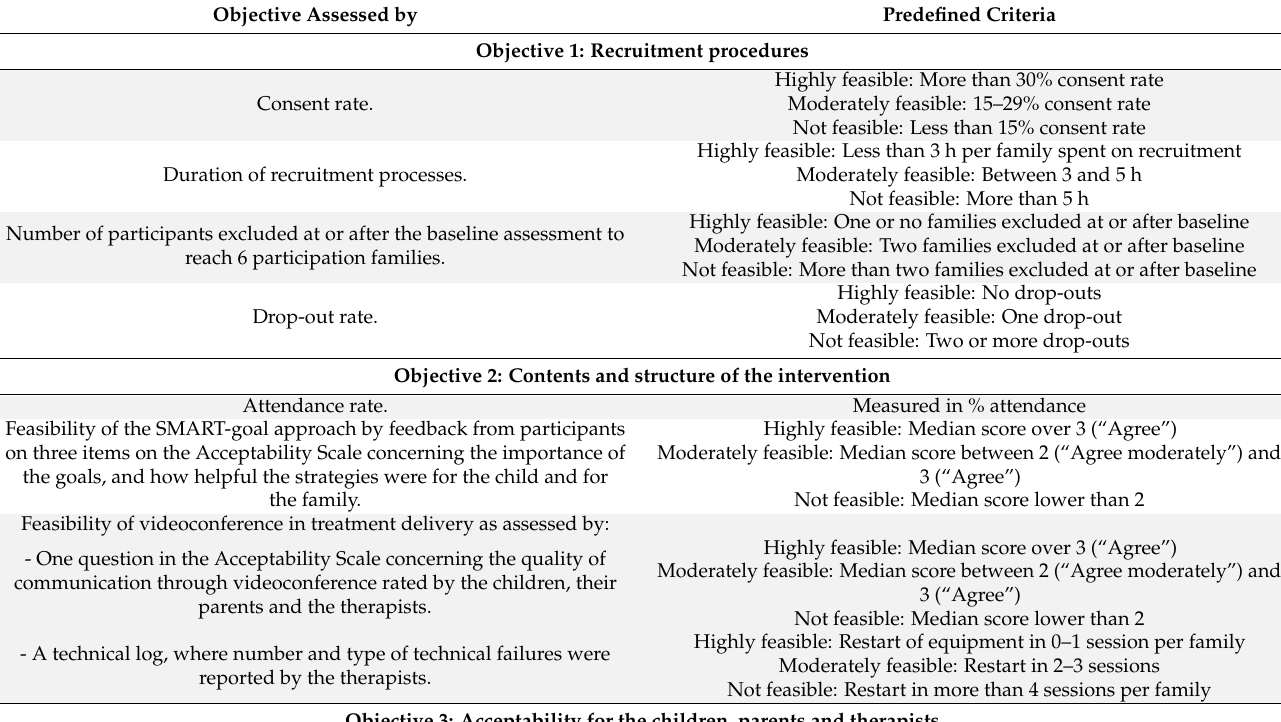
Table 2. Objectives of the feasibility evaluation with predefined